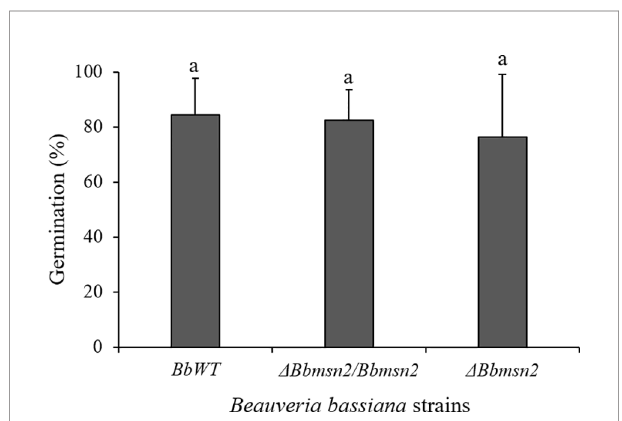
FIGURE 2 | Germination (%) of conidia of Beauveria bassiana strains: BbWT , D Bbmsn2/Bbmsn2 and D Bbmsn2 on the cuticle of Rhipicephalus microplus engorged females incubated at 26 ± 1°C and RH ≥ 90% for 48 h. Bars with the same letter do not differ signi fi cantly ( P ≥ 0.05) among treatments. Standard errors are based on three independent trials.